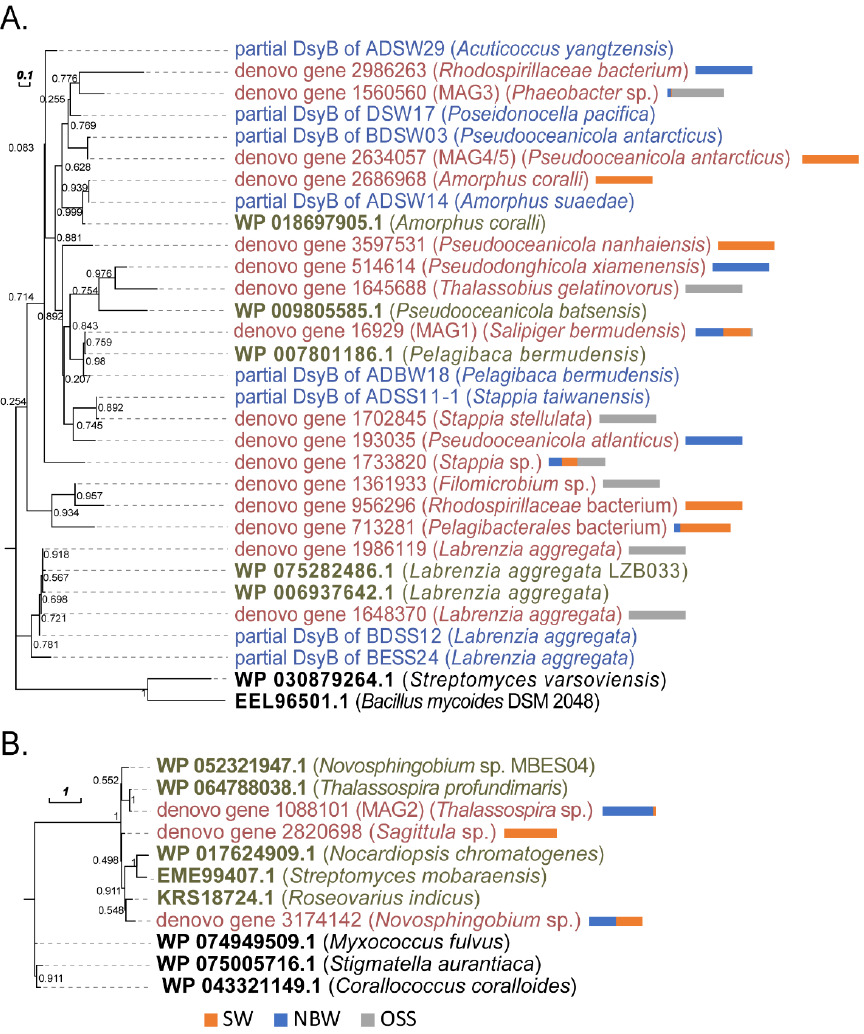
Figure 7. Maximum-likelihood phylogenetic tree of DMSP biosynthesis protein sequences retrieved from metagenomic data. ( A ) DsyB sequences from metagenomic data (red) and degenerate PCR (blue) in this study and functionally ratified DsyB (green). ( B ) MmtN sequences from metagenomic data (red) and functionally ratified MmtN (green). Nonfunctional DsyB and MmtN sequences were indicated in black. Branch lengths are measured in the number of substitutions per site, as indicated on the scale bar. Total abundance of sequences from metagenomic data in SW, NBW and OSS are indicated by the color bars (in percentage).